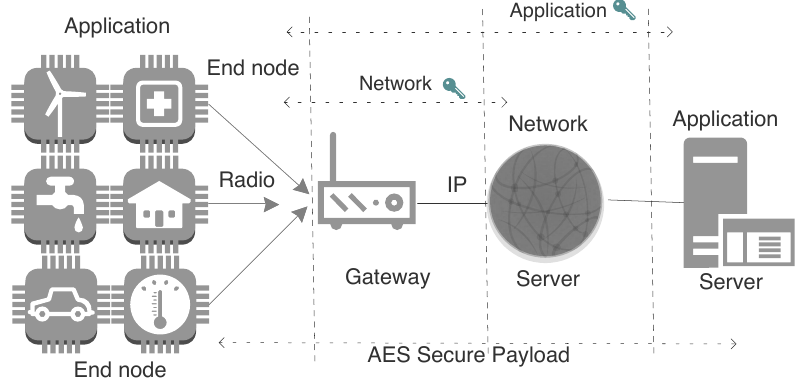
Figure 6. LoRaWAN network architecture.